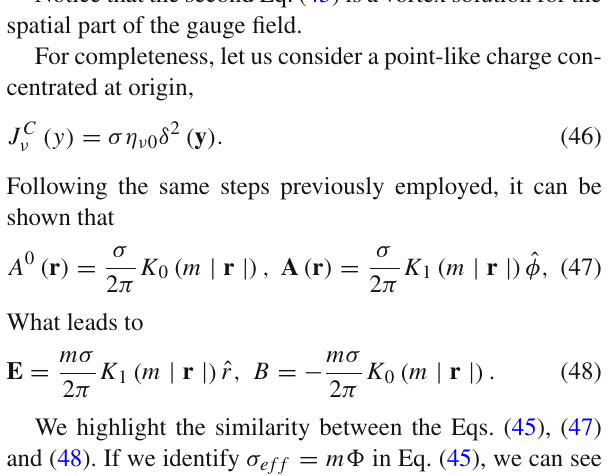
Notice that the second Eq. (45) is a vortex solution for the spatial part of the gauge field.